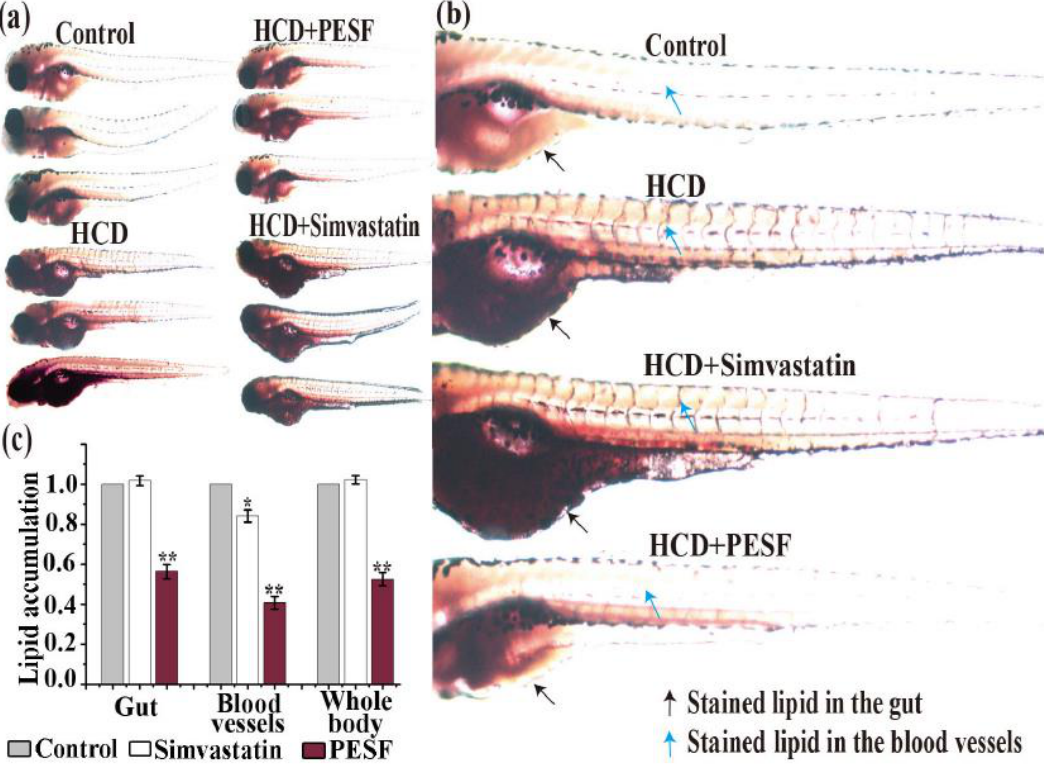
Figure 5. Comparison of PESF and simvastatin on inhibition of lipid accumulation in the zebrafish larvae model. ( a ) Representative photographs of zebrafish larval appearance with stainable lipids treated by PESF and simvastatin in the zebrafish model. Zebrafishes at 6 d.p.f were fed with HCD from 0 h to 24 h uninterruptedly and exposed to PESF (200 µg/mL) and simvastatin (200 µg/mL) from 12 h to 24 h and then stained by ORO at 24 h for image acquisition. For the zebrafishes in the normal group, no HCD was fed during the culture time. Conversely, the HCD group was fed with HCD for 24 h uninterruptedly. ( b ) Representative photographs of zebrafish larval appearance with stainable red lipids treated by PESF and simvastatin compared with the HCD group and the normal group. Black arrows point to lipids in blood vessels and blue arrows point to lipids in the gut. ( c ) Normalized quantification data of stainable lipid content in the zebrafish (gut, blood vessels, whole body) treated by PESF and simvastatin, correlated to microphotographs (a1), based on the HCD group set as 100%.